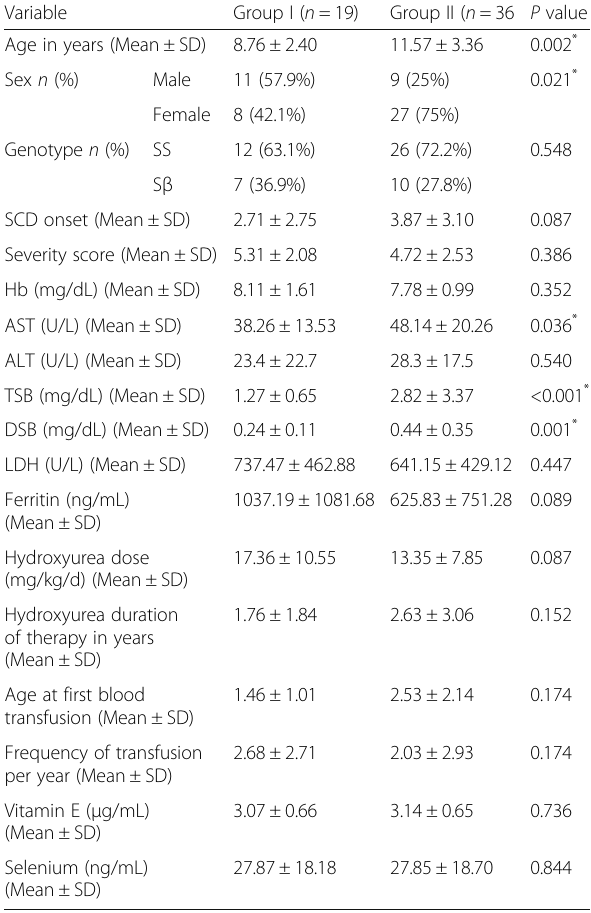
Table 4 Studied clinical and laboratory variables of SCD